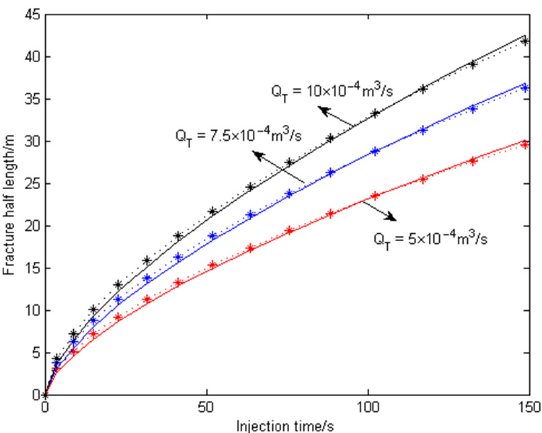
Figure 3. Comparison results of fracture half-length using different injection rates. (The solid lines represent analytical solutions, and the dotted lines numerical solutions)